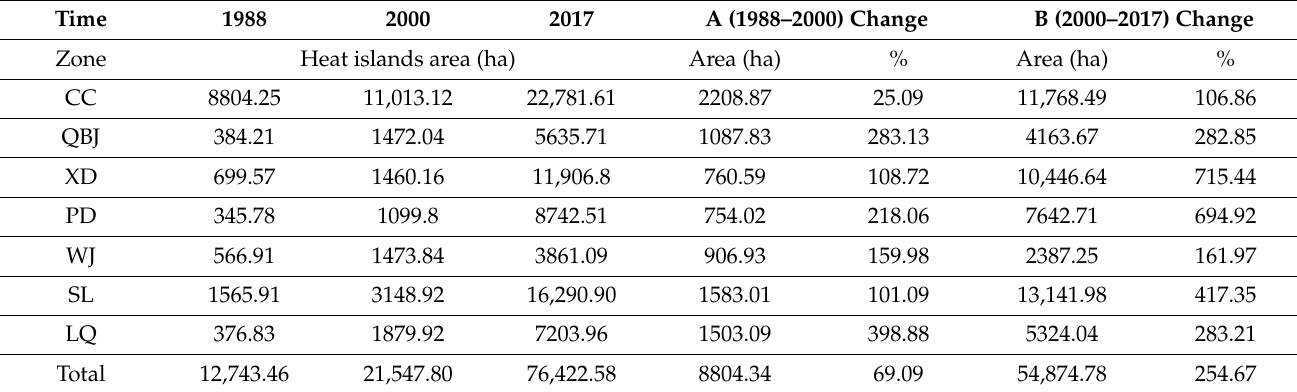
Table 1. Changes in the area of the heat islands area in the main urban area of Chengdu.